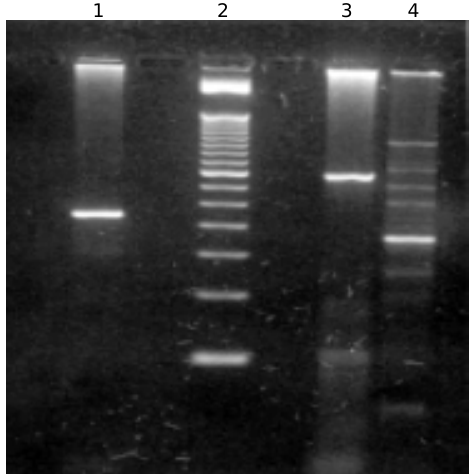
Figure 2. Agarose 2% gel